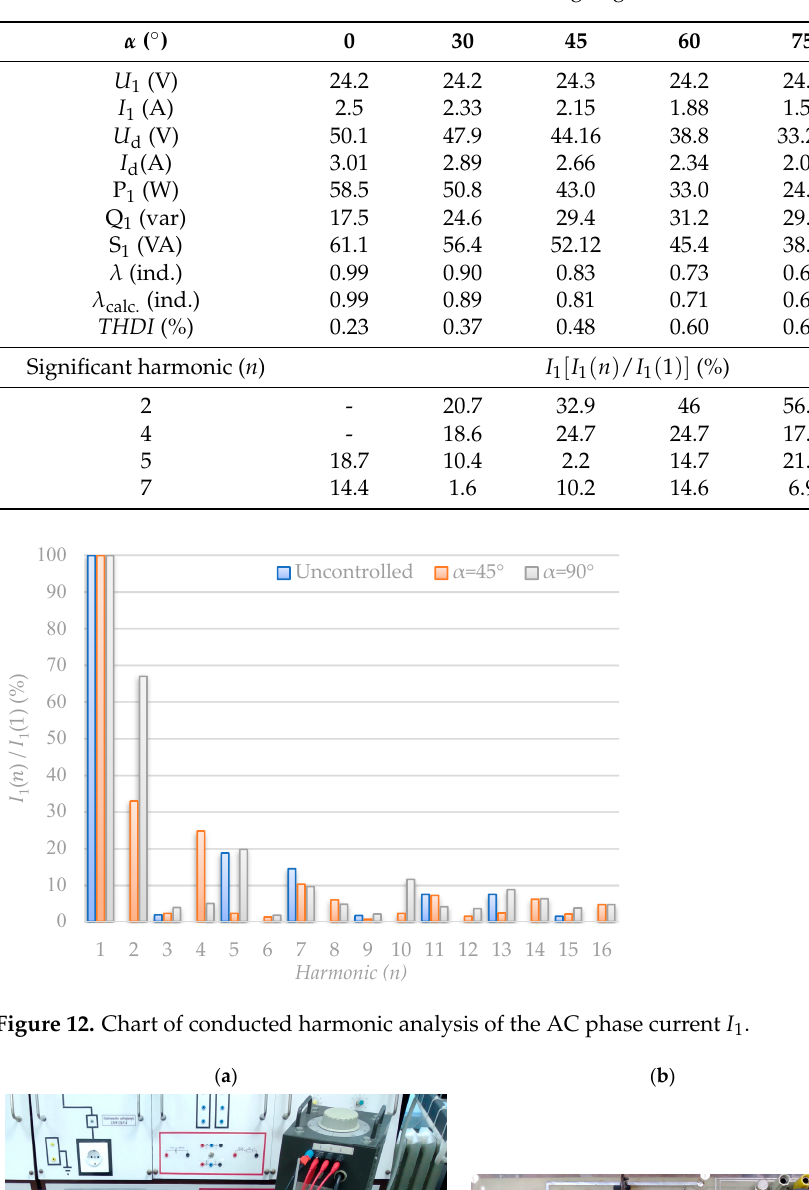
Table 2. Measured and calculated values for different firing angles.